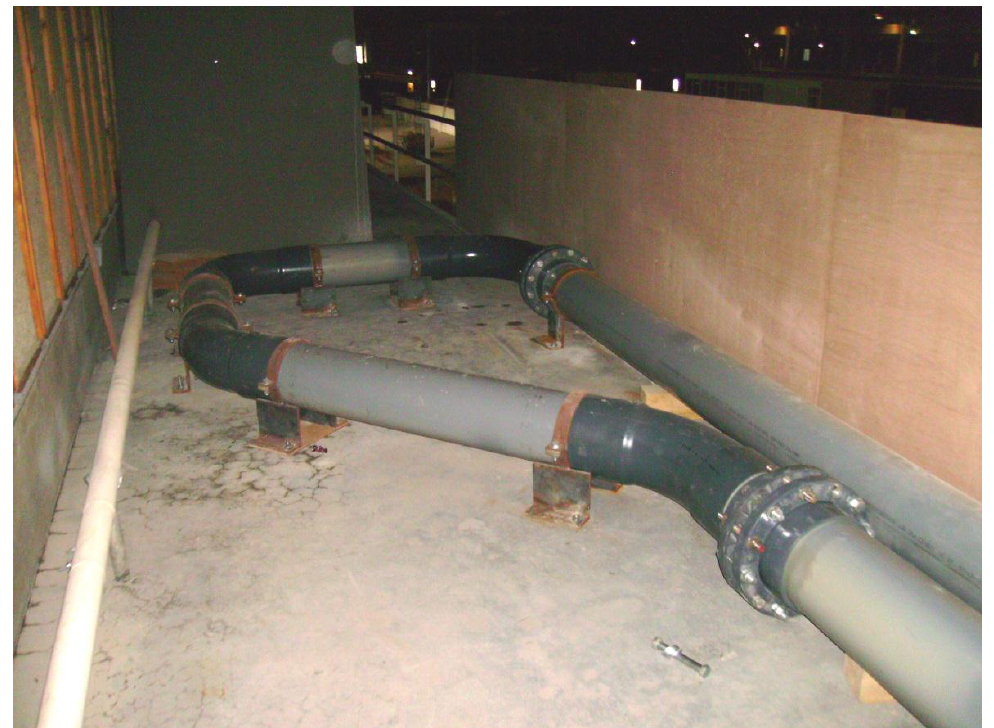
pipe turn section and the metal anchors (see the labelled long bend in Figs. 2 and 3).